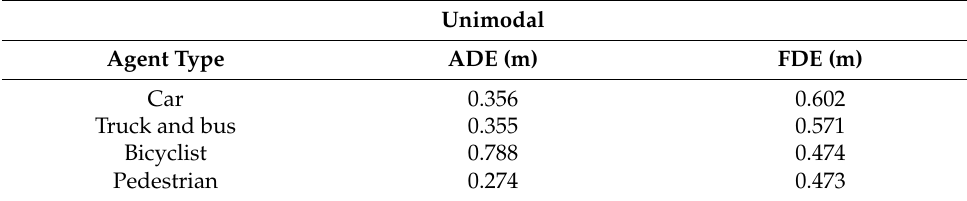
Table 3. Unimodal results for different agent types.